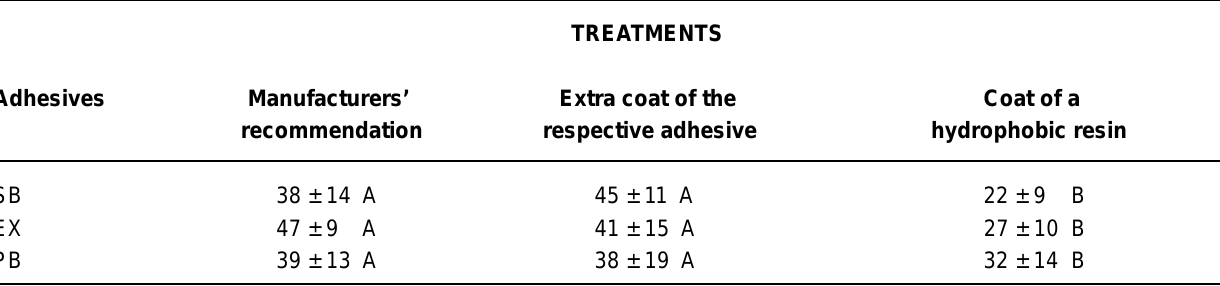
TABLE 2- Fluid flow (in percentage) across bonded-dentin when using two-step etch-and-rinse adhesives that were applied as recommended by manufacturers (controls) or coated with an extra coat of the respective two-step etch-and-rinse adhesive or with a more hydrophobic bonding resin